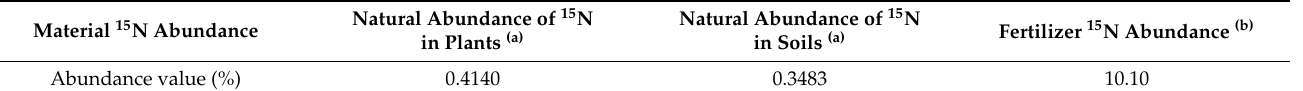
Table 3. The natural abundance of 15 N during the pot